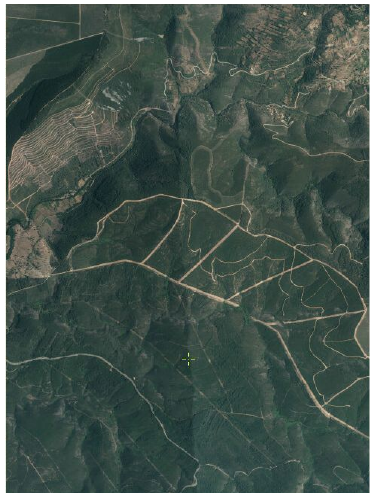
Figure 3: Original orthophoto mosaic (part 1)